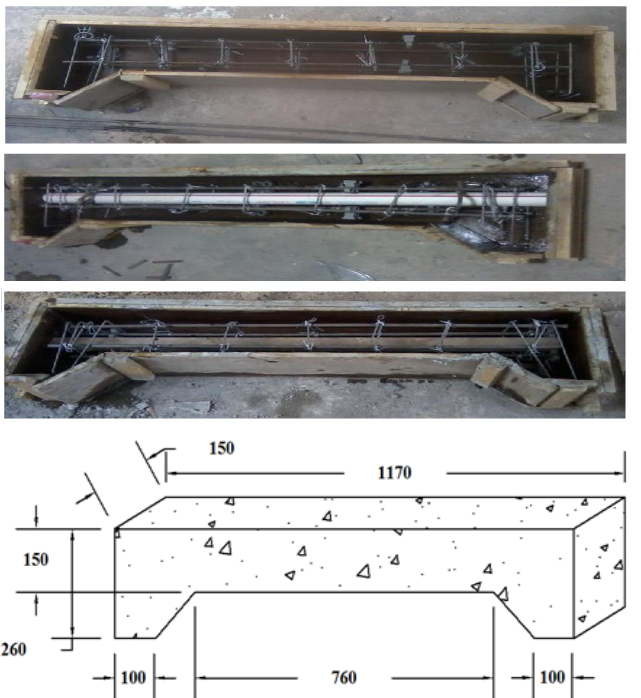
Figure 1. Moulds, steel reinforcement, recess locations and the dimensions of the non-prismatic RC beams. Reprinted from Ref. [23].